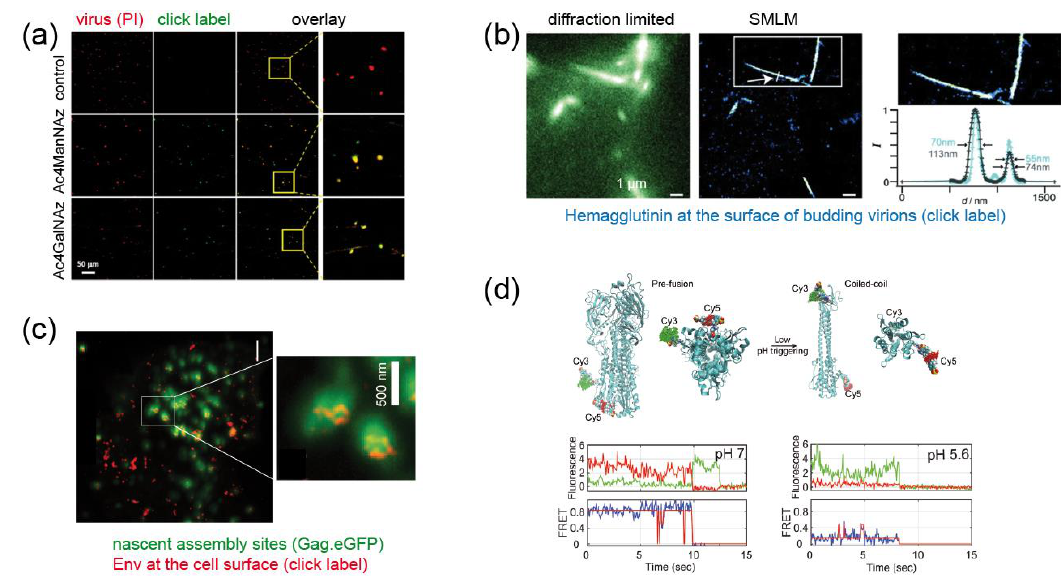
Figure 4. Examples for fluorescence labeling of viral proteins using click chemistry. ( a ) Metabolically labeled MV particles. The indicated sugars were added to the growth medium, virions were prepared and subjected to click labeling (green); propidium iodine staining (red) was performed to visualize all virions [29]. ( b ) Pulse-labeling of IAV HA exposed at the surface of budding virions using Cy3 and Cy5. The figure shows images of filamentous virus-like particles budding from the plasma membrane of a producer cell. Co-localization of both dyes at the nanoscale indicates incorporation of HA molecules synthesized at different times into the same particle [31]. ( c ) STED nanoscopy of click labeled HIV-1 Env in virus expressing cells shows clusters of Env molecules (red) recruited to viral assembly sites (visualized in diffraction limited mode via the structural protein Gag.eGFP; green) at the plasma membrane [32]. ( d ) Dual labeling of IAV HA at two different sites and smFRET reveal distinct conformational states of the molecule. Top, model of the modified protein in pre- and post-fusion conformation; bottom, smFRET traces recorded at pH conditions favoring the pre- (pH 7) and post-fusion (pH 5.6) state, respectively [33]. Images were modified from the indicated references, with permission.